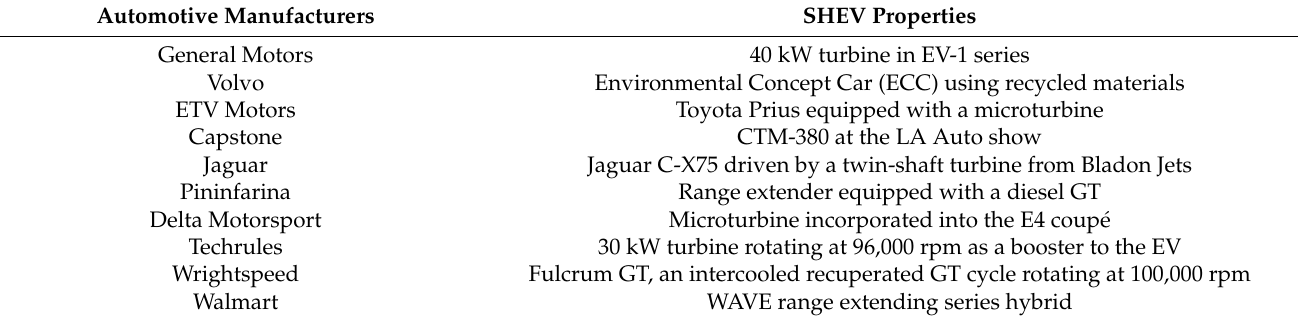
Table 1. State-of-the-art of SHEV configurations of different automotive manufacturers.